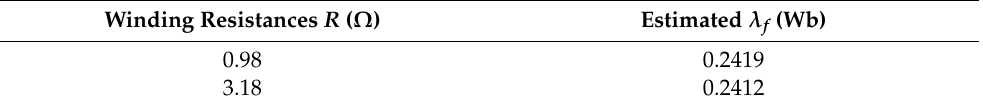
Figure 6. Measured q -axis command voltage with respect to rotor speed ( i d = 0, i q = 3 A).